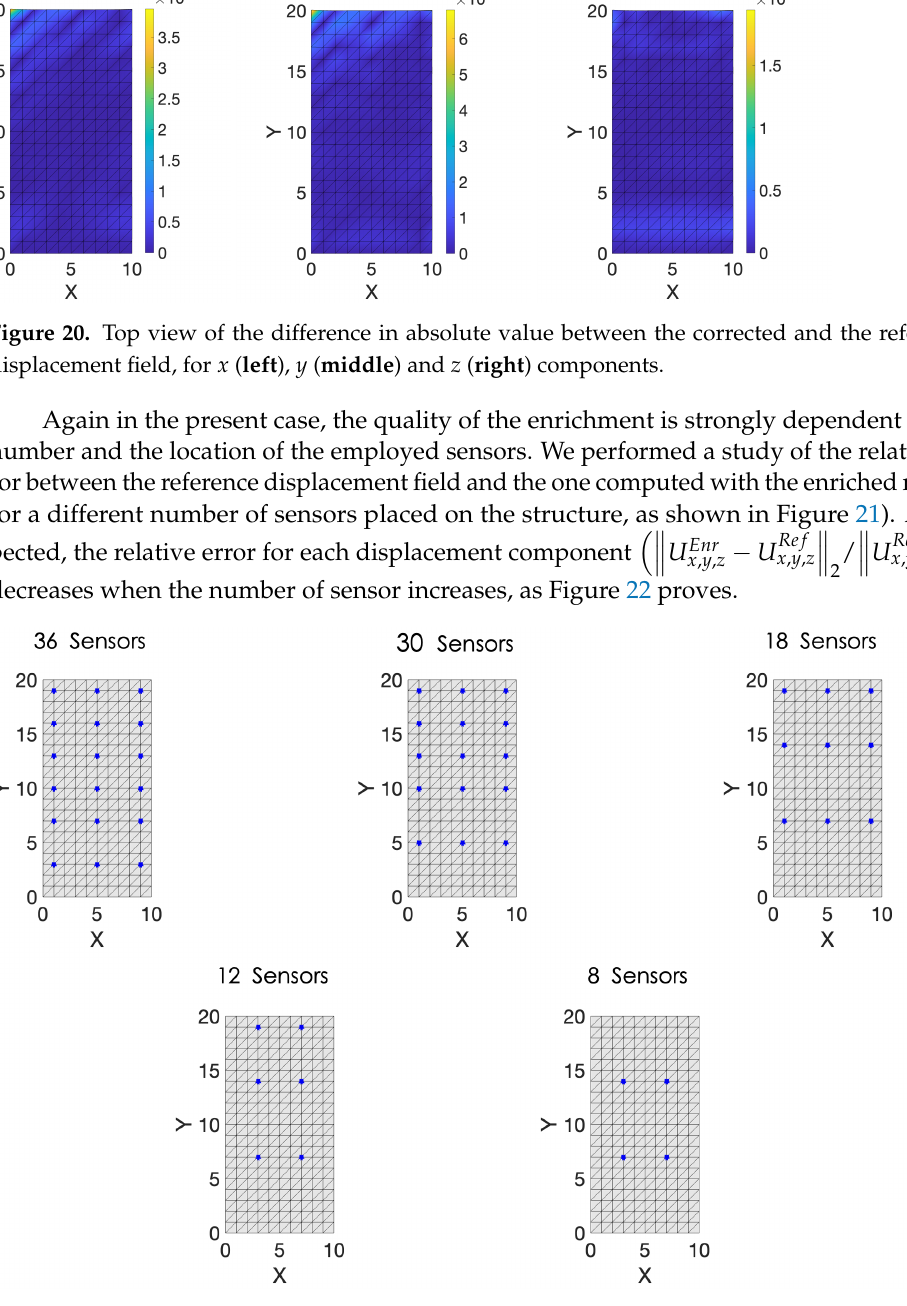
Figure 21. Top view of sensors location for different